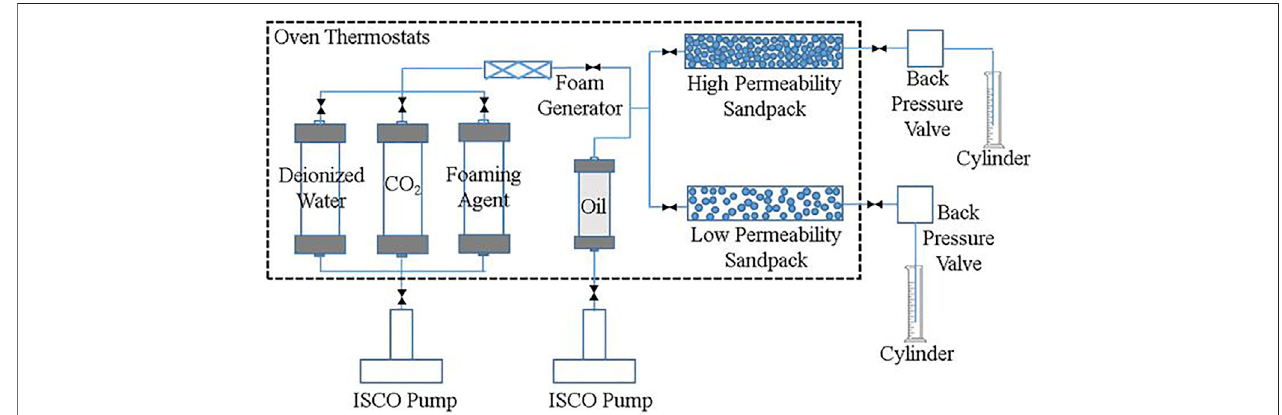
FIGURE 2 | Schematic illustration of dual-sandpack experimental